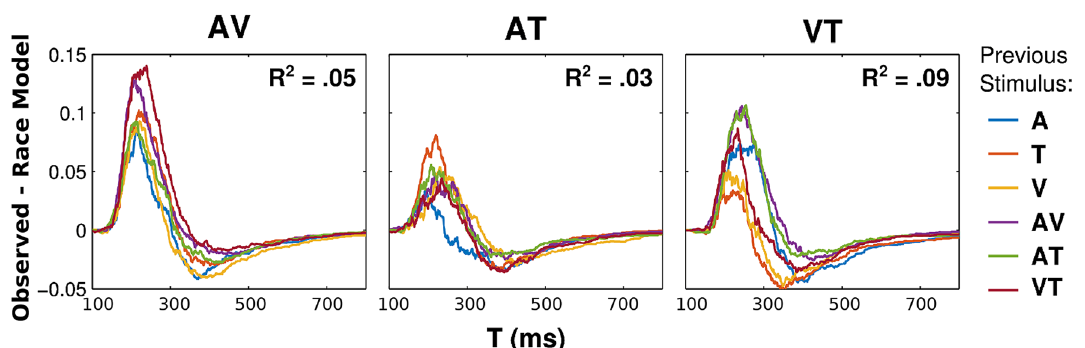
Figure 6. Race model violations (P[observed] − P[race model]) as a function of prior stimulus for each multisensory condition (AV, AT, and VT). Each curve is colored according to the previous stimulus (legend right). Effects of previous stimuli only explained a small proportion of variance (R 2 ) across all